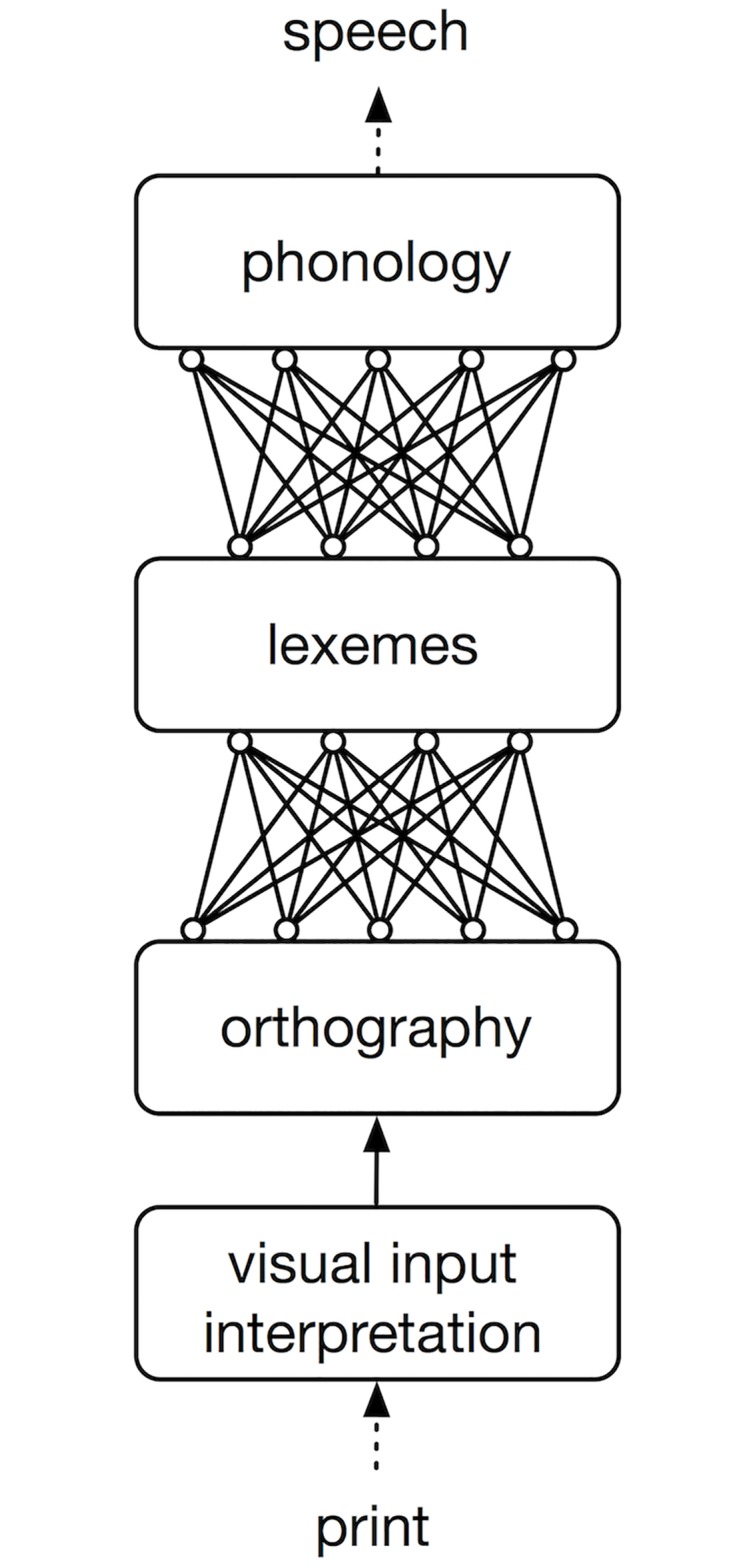
NDRA model.Basic architecture of the Naive Discriminative Reading Aloud (NDRA) model.